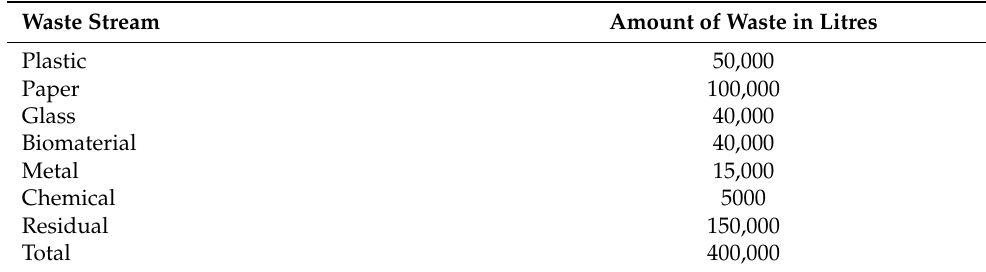
Table 5. Amount of waste generated onboard one river cruise vessel in